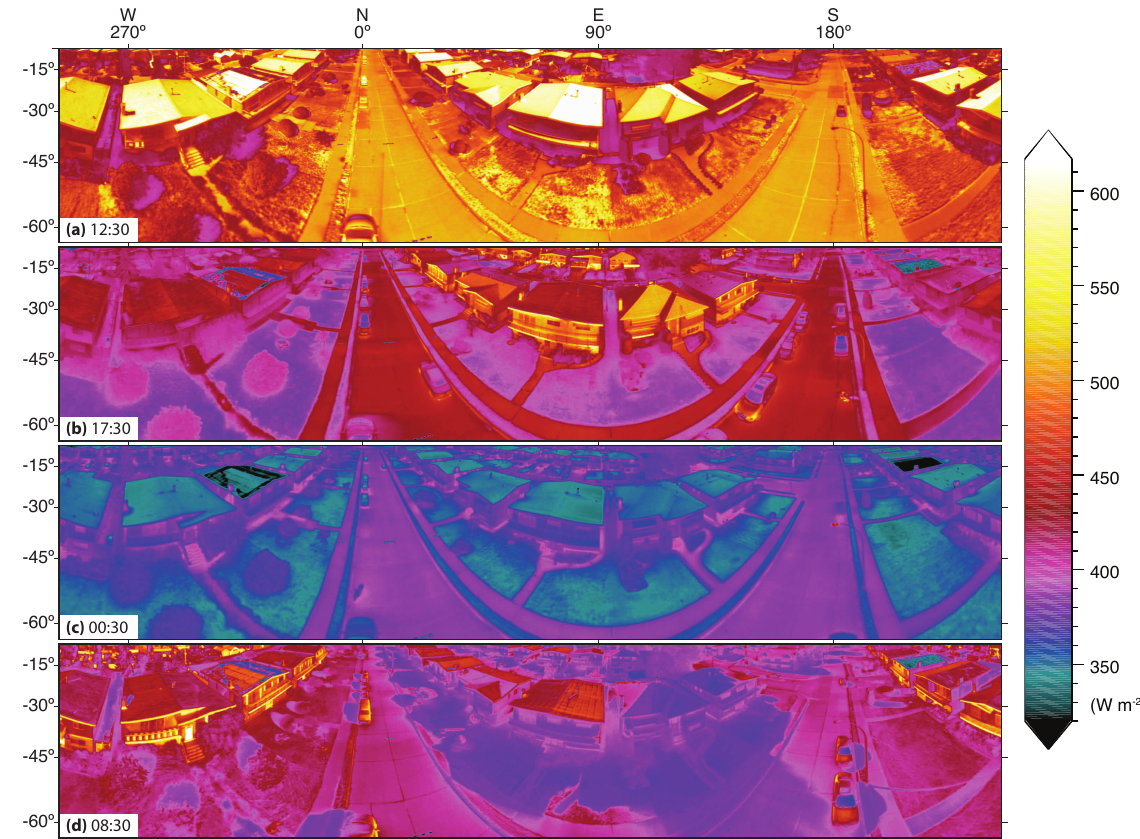
Figure 2. Selected time steps of the panoramic time sequential thermography (PTST) data set for 14 September 2008, 12:30 (a) , 17:30 (b) and 15 September 2008, 00:30 and 08:30. Each panorama is composed of ≈ 120 single images and projected using a conformal Mercator grid relative to the local horizon. See Supplement for PTST data from additional time